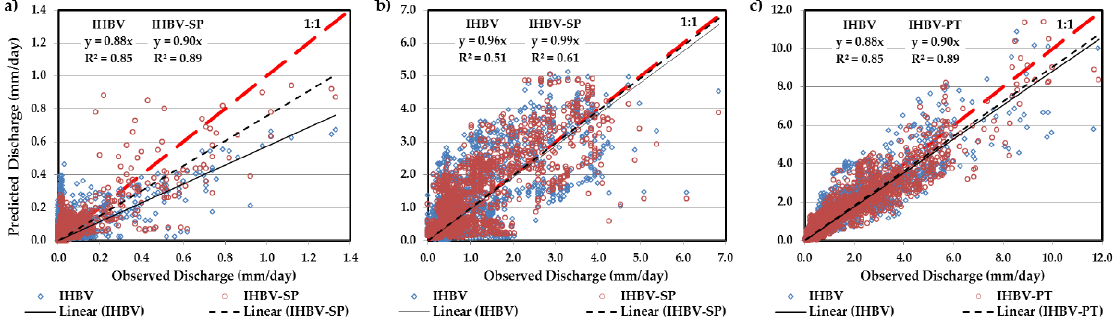
Figure 9. The scatterplots of the results by IHBV and the most suitable model during the test